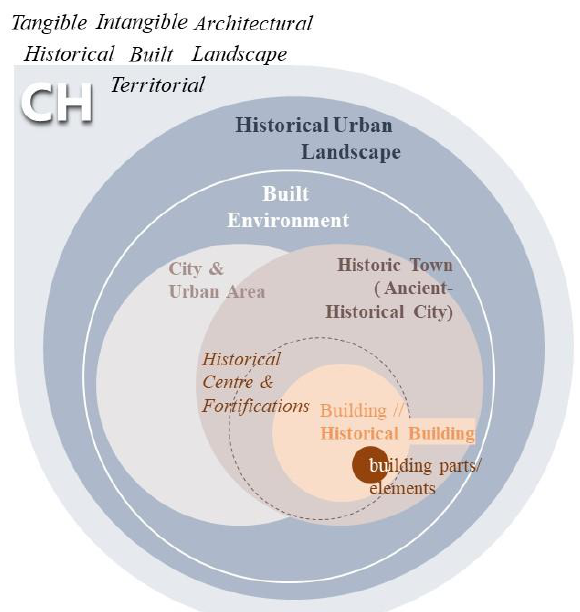
Figure 3. Figure 3. Some classes/spatial objects and relations based on standards definitions and spatial dimensions and